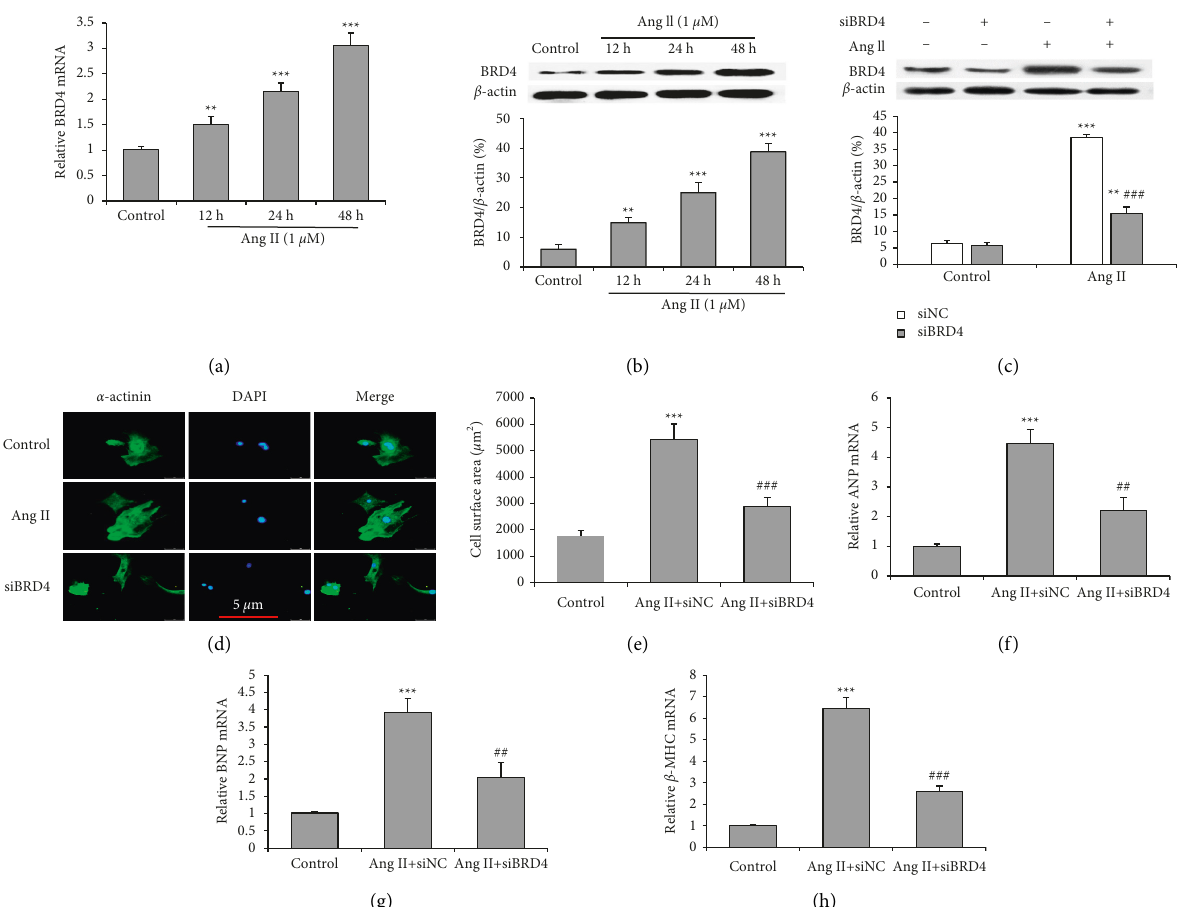
Figure 1: siBRD4 inhibits Ang II-induced cardiomyocyte hypertrophy. Cultured H9c2 cells were treated by vehicle (control) or Ang II (1 μ M) for 12, 24, and 48 hours. (a) The mRNA expression level of BRD4 in Ang II-induced H9c2 cells. (b) The protein expression level of BRD4 in Ang II-induced H9c2 cells. (c) The BRD4 expression was silenced using siRNA in H9c2 cells and validated using a Western blot. (d) H9c2 cells were stained with α -actinin (green) and DAPI (blue) to show morphology and size; representative photographs are shown (scale bar:10 μ m). (e) Cardiomyocyte hypertrophy was evaluated by the surface area. mRNA expressions of the ANP (f), BNP (g), and β -MHC (h) genes were evaluated using a real-time PCR. All data are expressed as mean ± SD, and the experiment was performed three times, ∗∗ P < 0 . 01, ∗∗∗ P < 0 . 001 vs. control group; ### P < 0 . 001 vs. Ang II +siNC